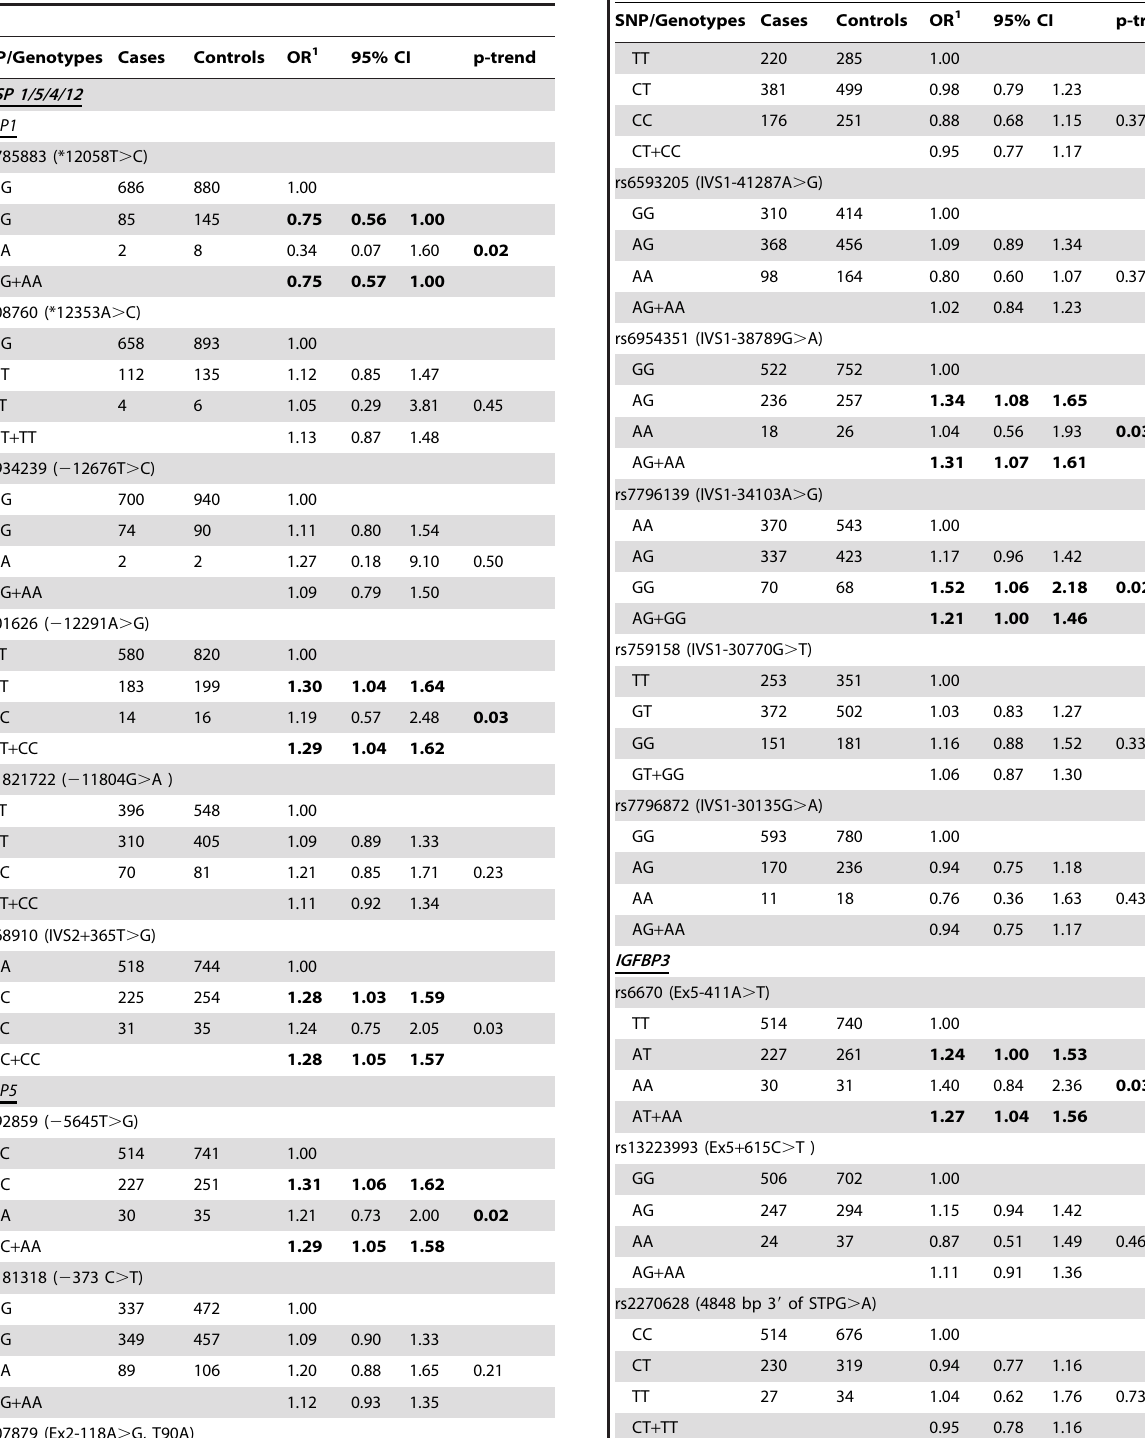
Table 4. Association between Selected Polymorphisms and Renal Cancer